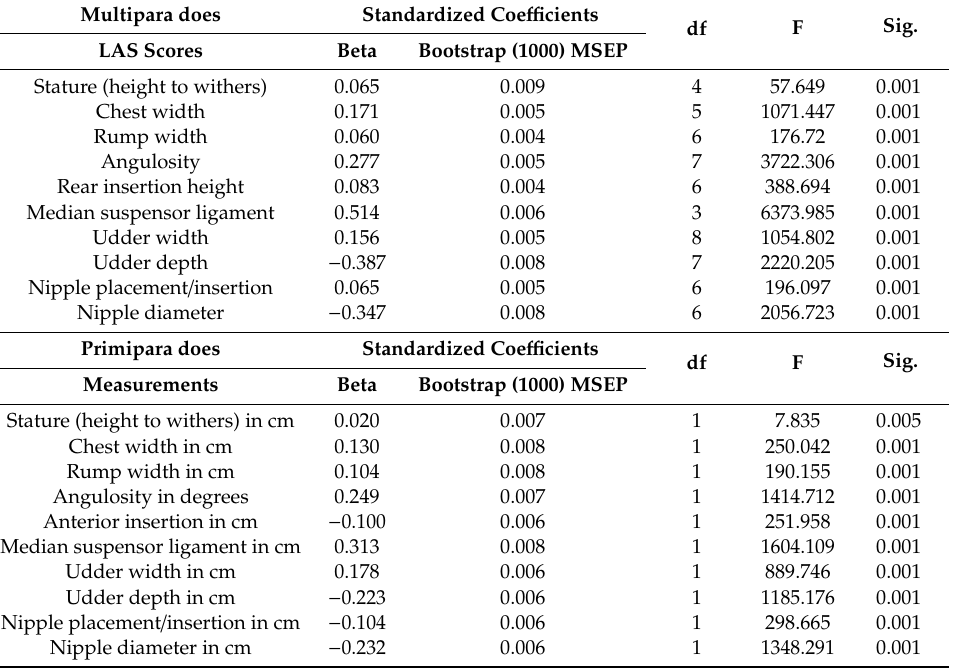
Table 5. β -standardized coe ffi cients to replace the Z score in each of the respective equations in Supplementary Table S5 and a 0.632 bootstrap mean squared error of prediction (MSEP) for the comparison of model validity between the two linear regression models using linear appraisal traits as opposed to Murciano-Granadina zoometric traditional assessment in